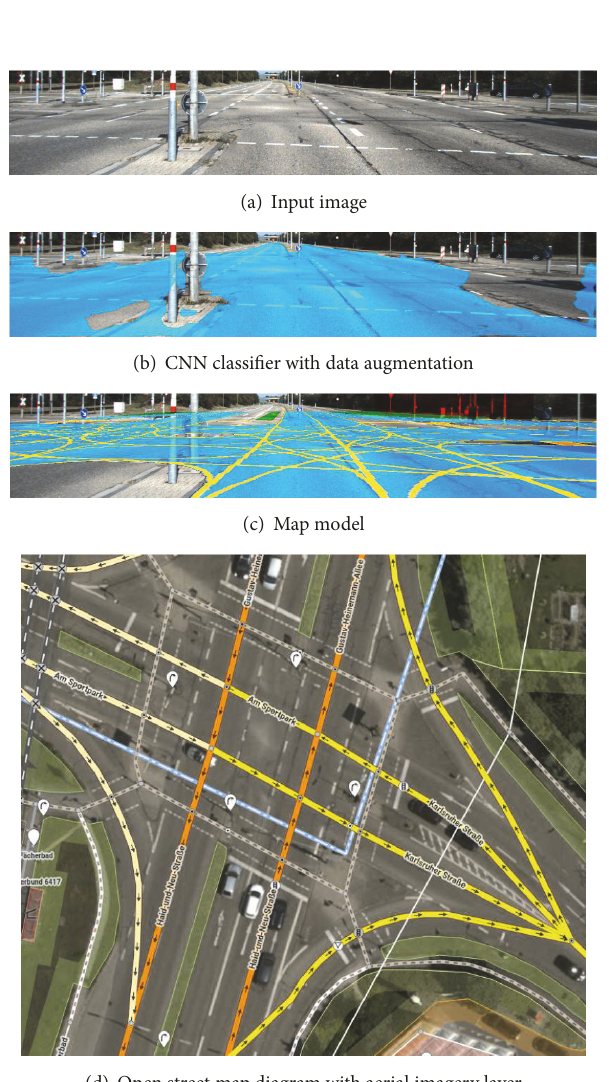
Figure 11: Example of a very complex intersection where the map- based modelis not well fitted to the road limits. However, it provides richer high-level information to be used in autonomous navigation